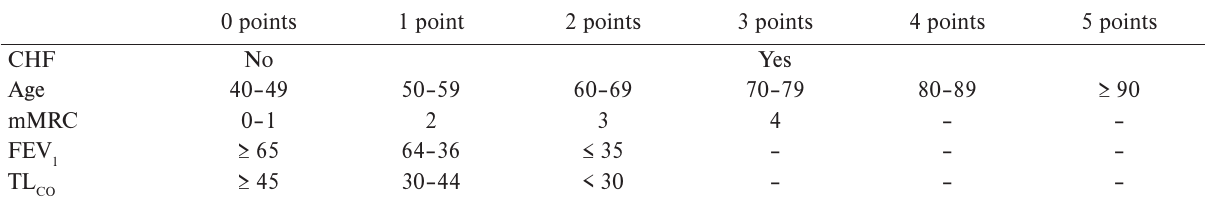
Table 2. Assignment of points for the CADOT